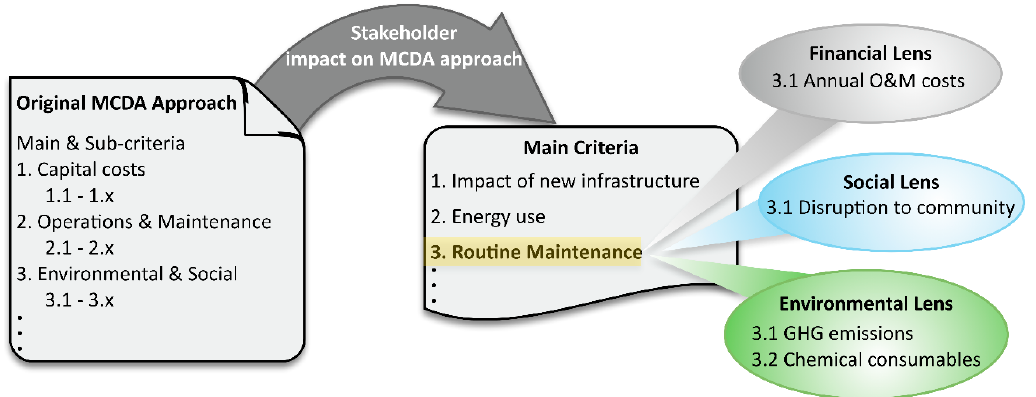
Figure 3. Hybrid multi-criteria decision analysis-triple bottom line (MCDA-TBL) Approach. Water 2018 , 10 , x FOR PEER REVIEW